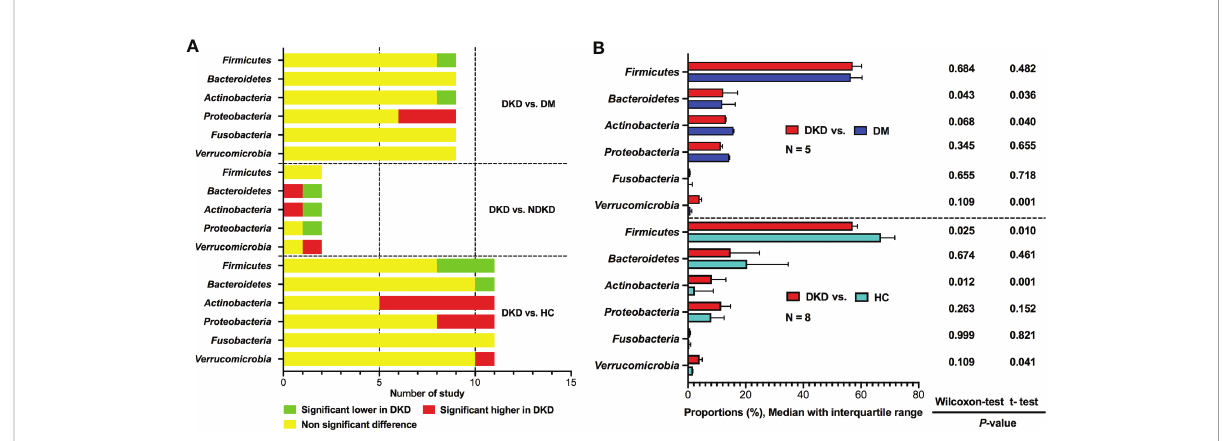
FIGURE 2 Qualitative and quantitative analysis of gut microbiota at the phylum level. (A) Qualitative comparisons at the phylum level; (B) Comparisons of average abundances at the study level for bacterial phylum. DKD, diabetic kidney disease; NDKD, non-diabetic kidney disease; DM, diabetes mellitus; HC, healthy controls; N, number of